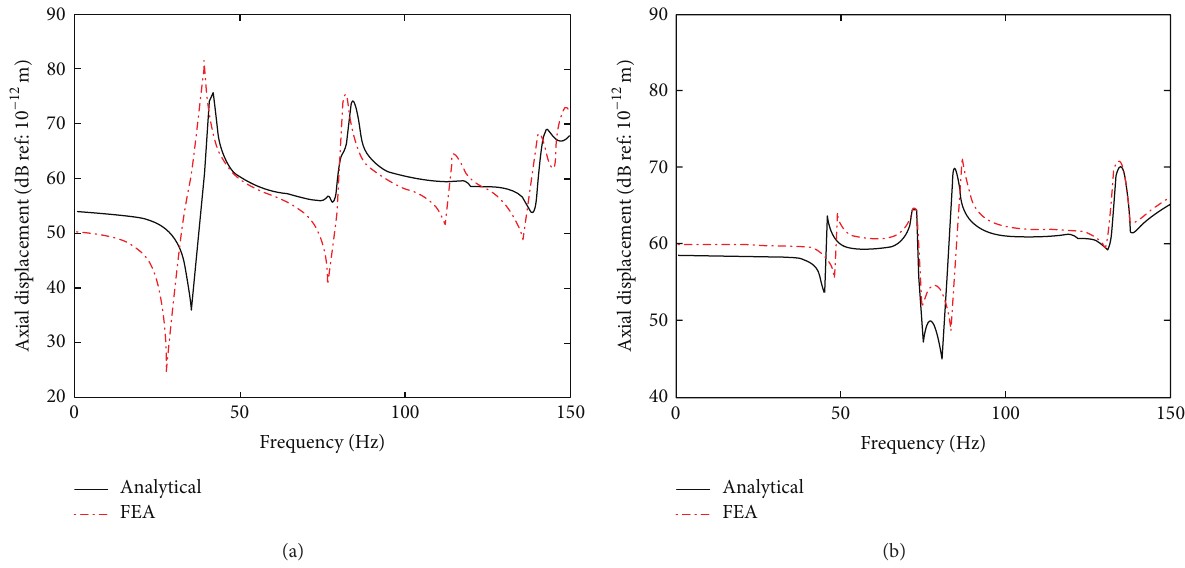
Figure 6: Comparison with FEA results when the space or size of stiffeners changes. (a) Results when the space between stiffeners 𝑑 = 0.42 ; (b) results when cross-section of the stiffeners is 0.028 m × 0.04 m.